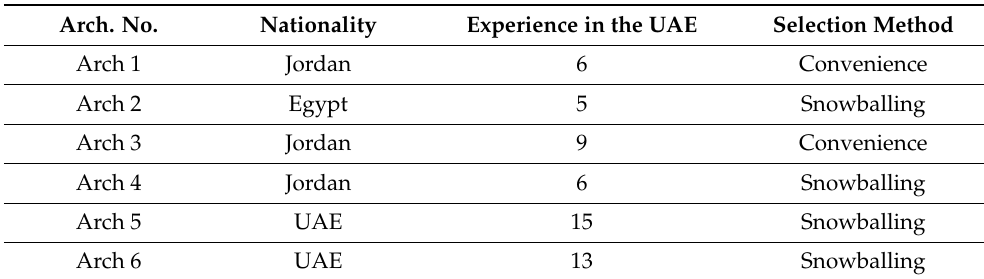
Table 4. Architect selection